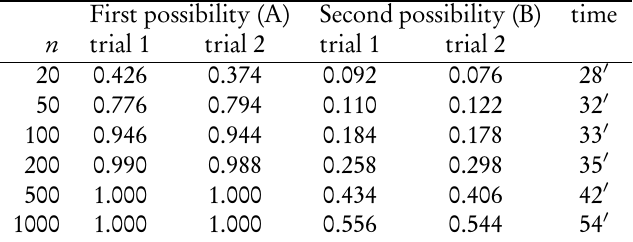
Coverage rates for a 4 X 4